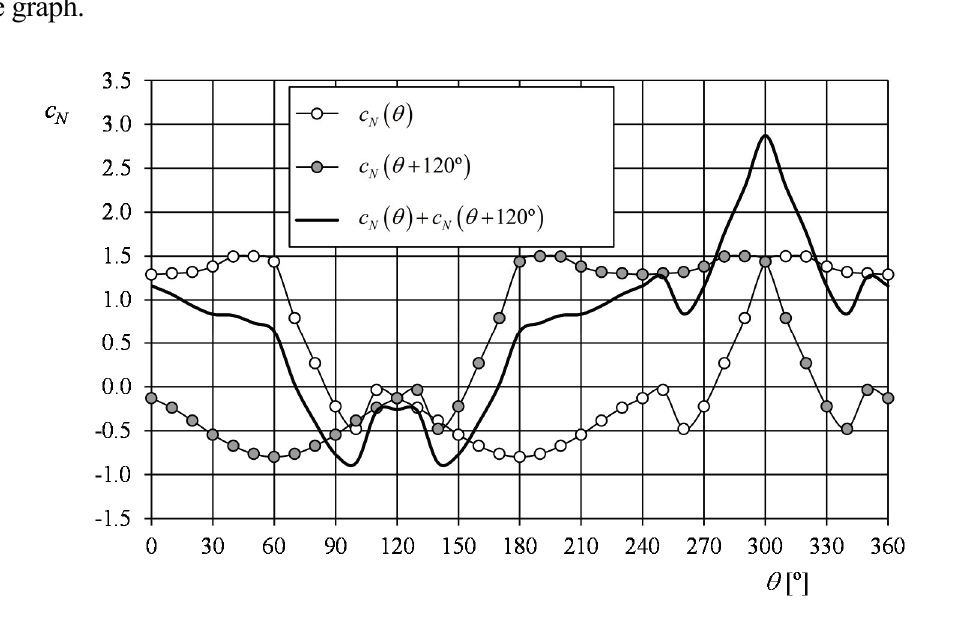
Figure 19. Normal-to-the-cup aerodynamic cup coefficients, c N ( θ ) and c N ( θ + 120°), corresponding to each one of the two cups of the 1-missing-cup damaged rotor (left picture in Figure 16), in relation to the rotor’s position. The addition of both coefficients is also included in the